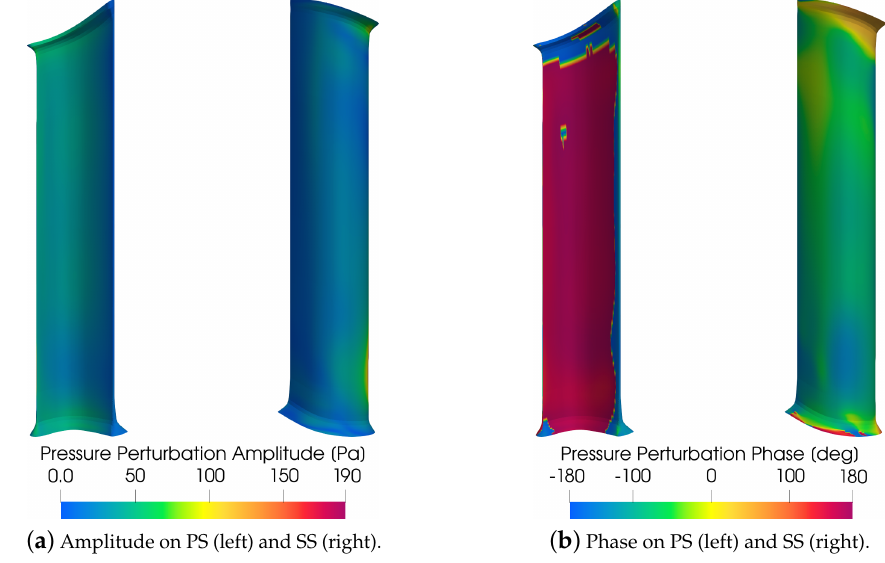
Figure 11. Unsteady forcing at EO = 7 and ND = −